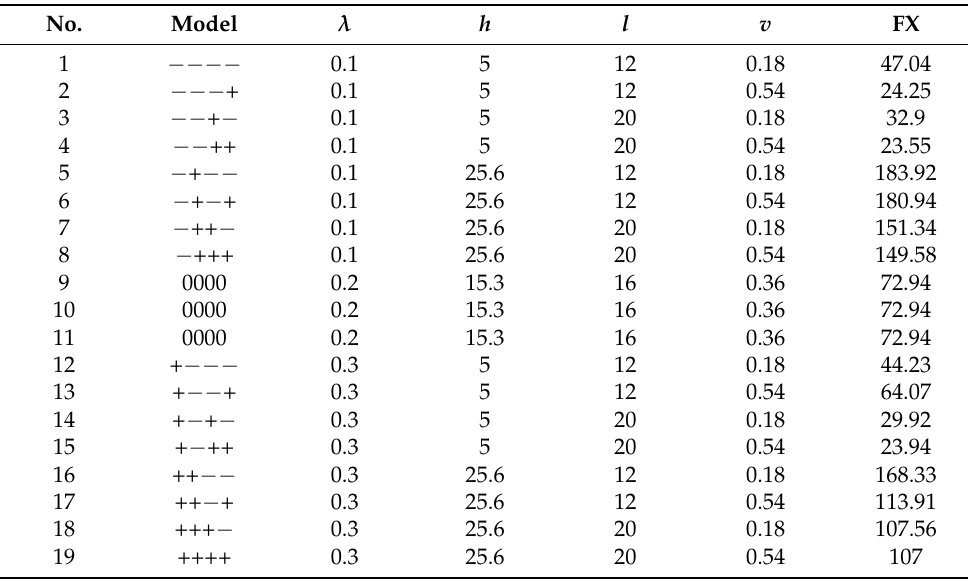
Table 4. The full factorial experimental